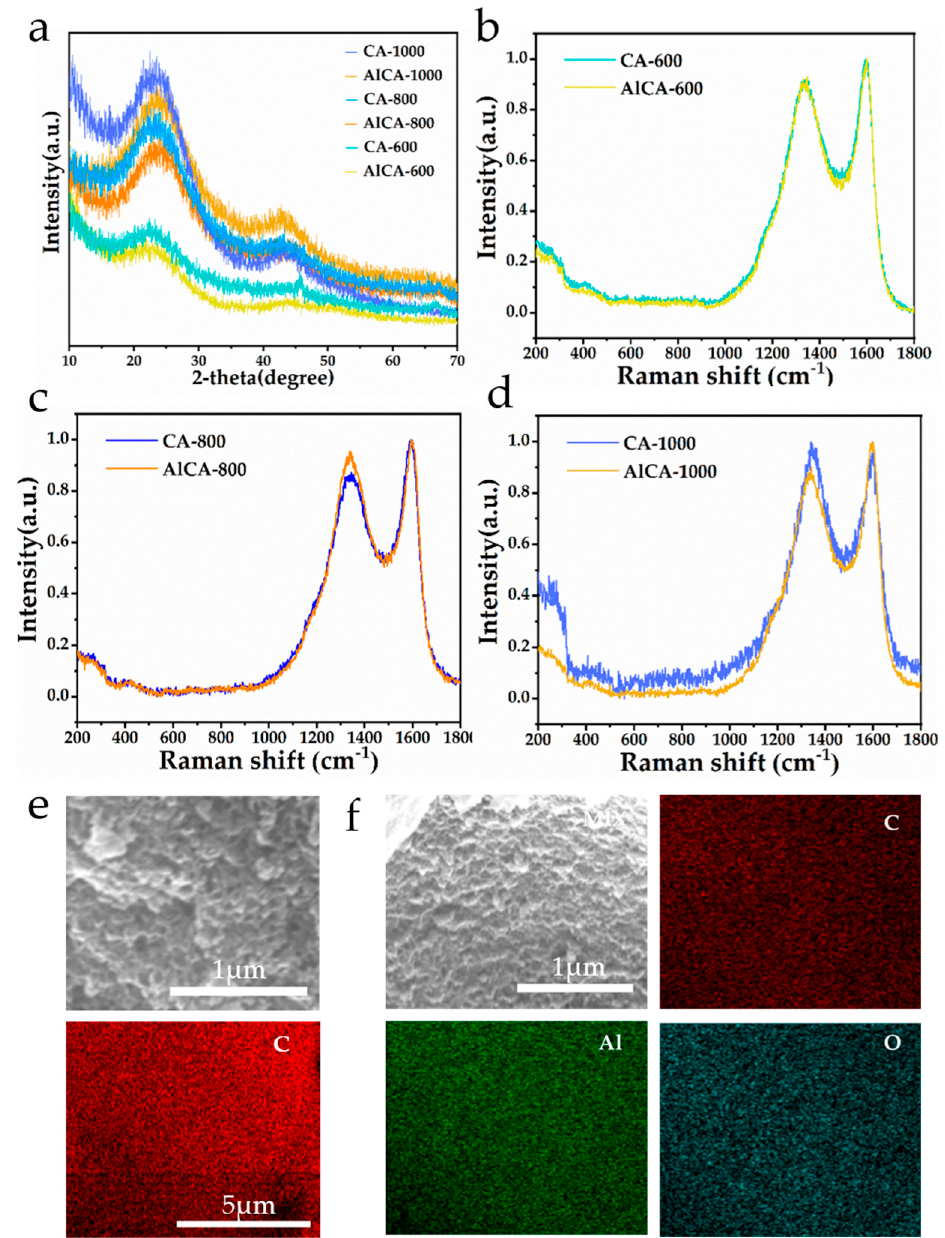
Figure 2. ( a ) XRD pattern for CAs and AlCAs, Raman spectra for ( b ) CA–600 and AlCA–600, ( c ) CA–800 and AlCA–800, ( d ) CA–1000 and AlCA–1000, EDS mapping for ( e ) CA–800 and ( f ) AlCA–800.